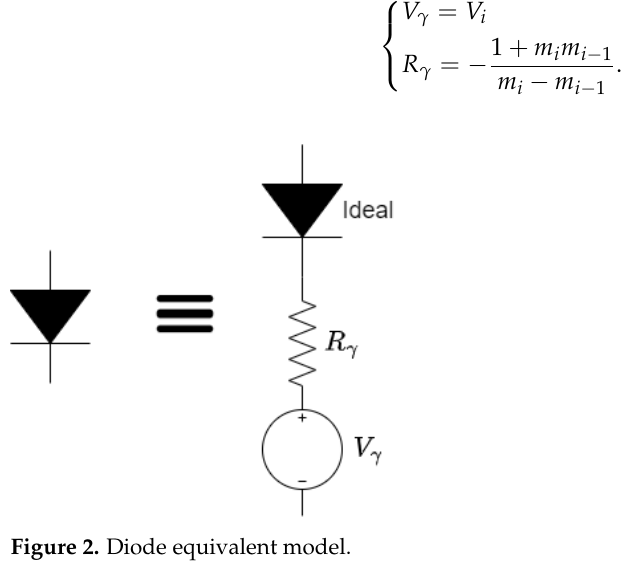
Figure 2. Diode equivalent model.